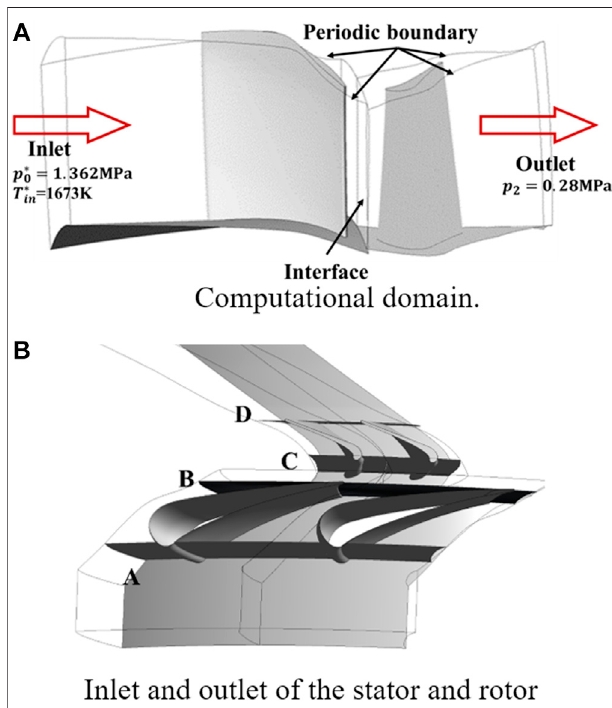
FIGURE 1| Geometry. (A) Computational domain. (B) Inlet and outlet of the stator and rotor.